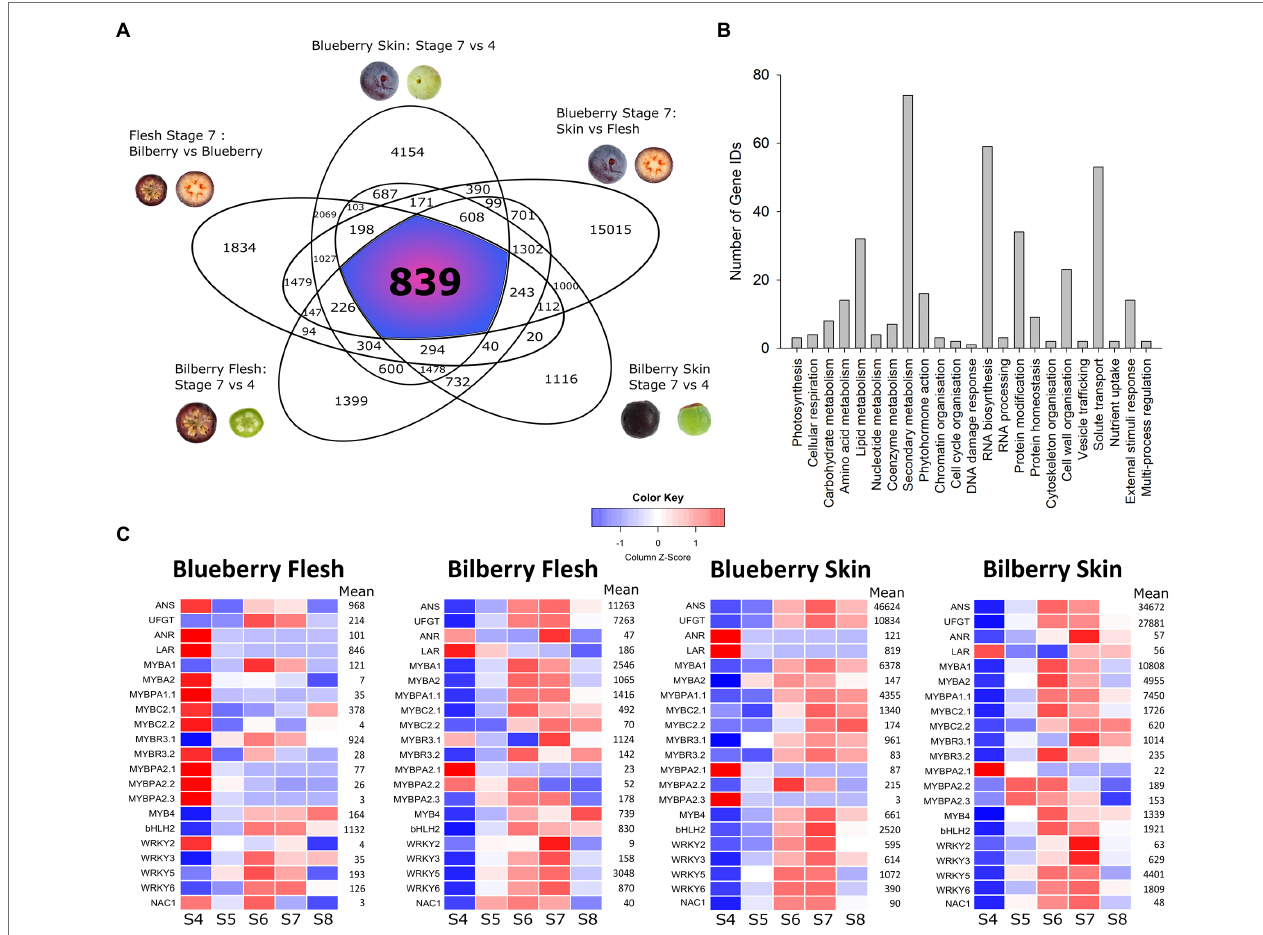
FIGURE 1 | Differential expression analysis of the blueberry and bilberry RNA-seq dataset. (A) Highly differentially expressed genes (HDEGS) were identified by comparing high and low anthocyanin-producing tissues. HDEGs were described as having a log2-fold change greater than 2 in high-anthocyanin tissues, with an –adjusted p -value < 0.01. HDEGs consistently present across each comparison were identified and visualized as a Venn diagram. Comparisons were between blueberry skin S7 vs. S4, blueberry S7 skin vs. flesh, bilberry skin S7 vs. S4, bilberry flesh S7 vs. S4 and blueberry vs. bilberry S7 flesh. (B) HDEGs consistent across all comparisons were annotated using Mercator4 (V2.0), which assigned Mapman bin numbers. This was visualized as a bar graph in SigmaPlot (V14.0). (C) The developmental expression patterns of candidate anthocyanin transcription factors (TFs), SG5 MYBPA1-TFs and representative biosynthetic genes were visualized as a heatmap. ANS and UFGT represented anthocyanin biosynthesis while ANR and LAR represented proanthocyanidin (PA) biosynthesis. Raw counts were normalized via the median of ratios method. Count data were visualized as Z -scores, which calculated how many standard deviations a data point was from the mean of a gene across all samples in the given tissue, with blue and red representing negative and positive Z -scores, respectively. Mean represents the mean counts for each gene, in each tissue type, across